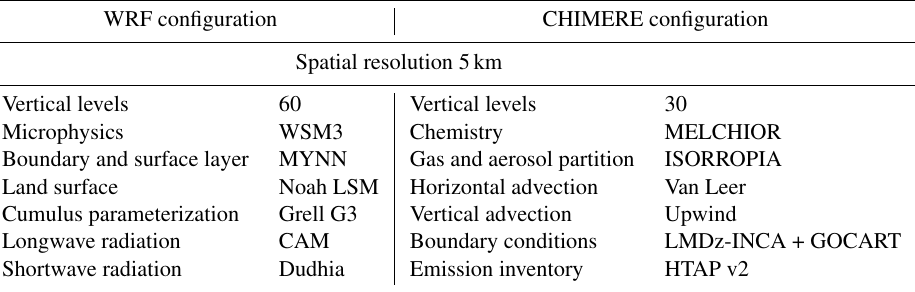
Table 1. WRF and CHIMERE